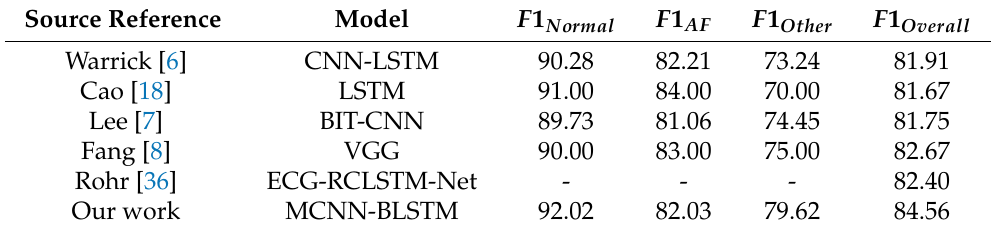
Figure 3. Scatter diagram based on features learned from different branch. Panels ( a – d ) correspond to the features extracted by the first branch, the second branch, the third branch and the mdoel MCNN-BLSTM, respectively. Table 7. Comparison between the related work and the method proposed in this